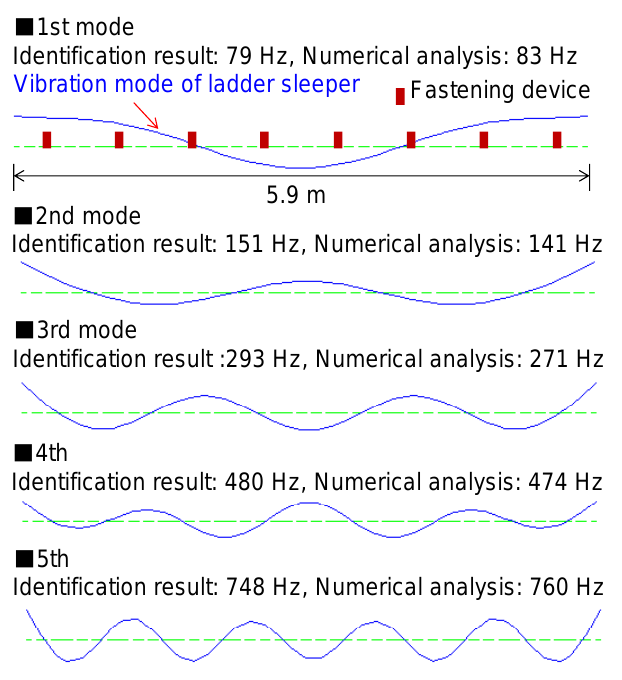
Figure 7. Identification results of natural frequency and vibration mode shape of ladder sleepers.